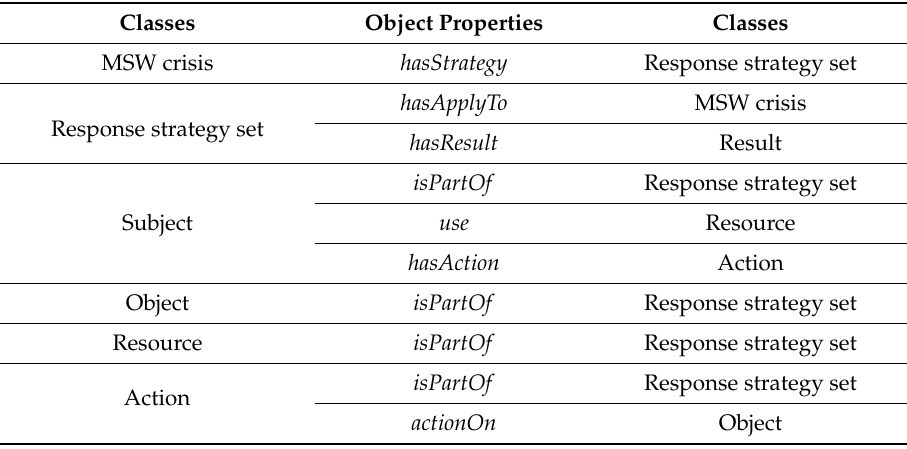
Table 1. The relations in response strategy ontology model.